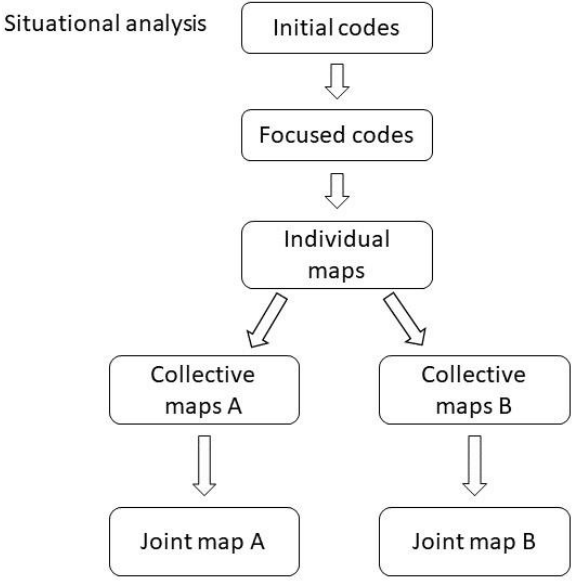
Figure 1. Flowchart describing the analytical progression inspired by Clarke [30]. A represents Sequence A, i.e., relocation happened before retirement, and B represents Sequence B, i.e., retirement happened before relocation.